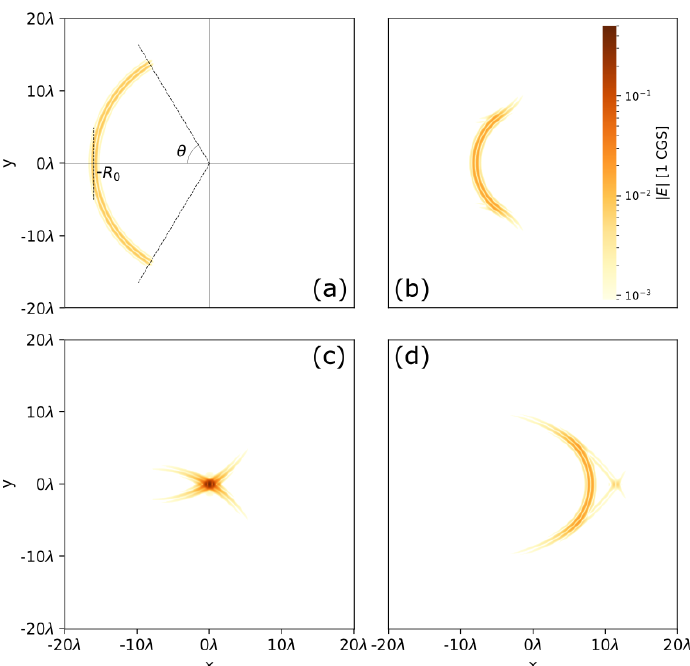
Figure 1. An example of simulation of the tight focusing problem. The electric field intensity is shown for ( a ) t = − R 0 / c , ( b ) t = − R 0 /2 c , ( c ) t = 0 and ( d ) t = R 0 /2 c with f − number = 0.3 ( θ ≈ 1 rad), λ = 1 µ m, R 0 = 16 λ , L = 2 λ , ε = 0.1 rad, P 0 = 1 W. The pulse propagates towards positive x direction, the transverse directions are spanned by y and z axes (see Equation